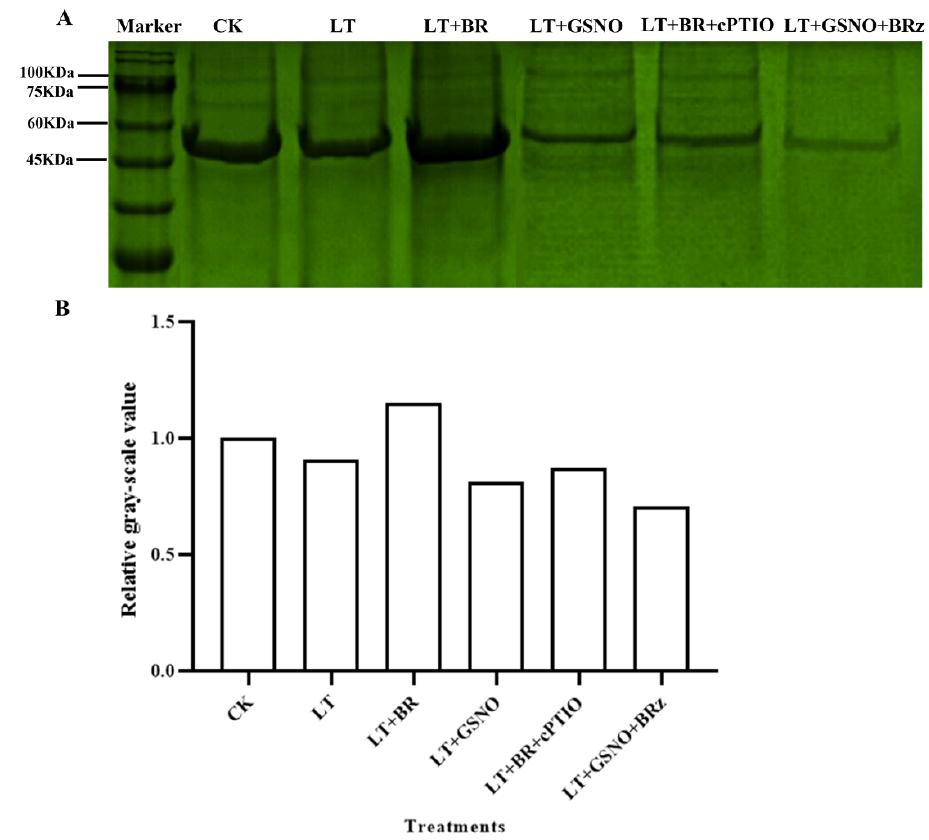
Figure 6. Effects of BR, GSNO, cPTIO and BRz treatments on total nitrosylated protein in Chinese cabbage under low-temperature stress. Total nitrosylated protein was determined by biotin switch assay. ( A ) Staining results of total nitrosylated protein in mini Chinese cabbage under CK (26/18 °C, day/night), LT (4/4 °C, day/night), LT + 0.05 mg/L BR, LT + 50 µM GSNO, LT + 0.05 mg/L BR + 50 µM cPTIO and LT + 50 µM GSNO + 10 µM BRz. ( B ) The relative gray-scale value of total S -nitrosylated protein under different treatments.